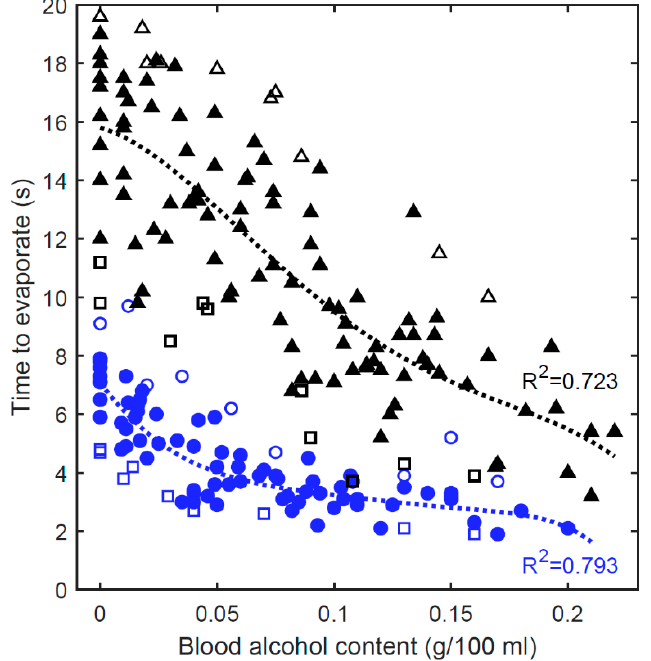
Figure 4. Utilization of our breathalyzer in a real-world environment. The weak correlation between the breath evaporation time and the BAC is greatly improved by considering a few measurable parameters. Blue markers: humidity of 0.32. Black markers: humidity of 0.53. Empty markers: detected anomalies.